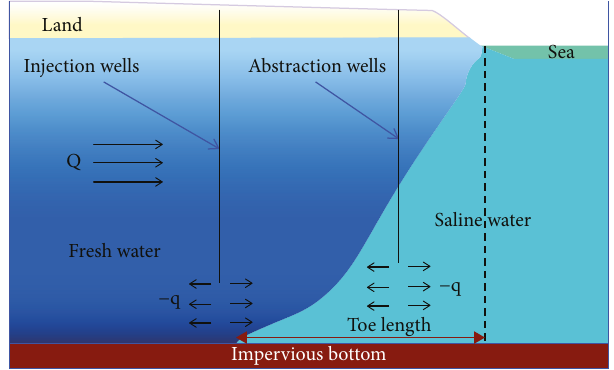
Figure 1: Simpli fi ed diagrams showing the injection wells and abstraction wells for the restoration of salt